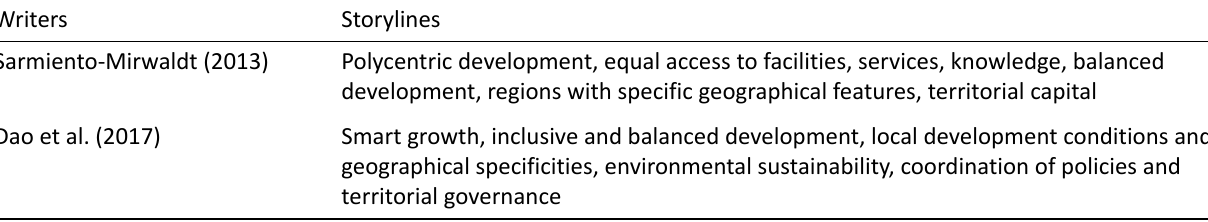
Table 2. Territorial cohesion’s storylines. Writers